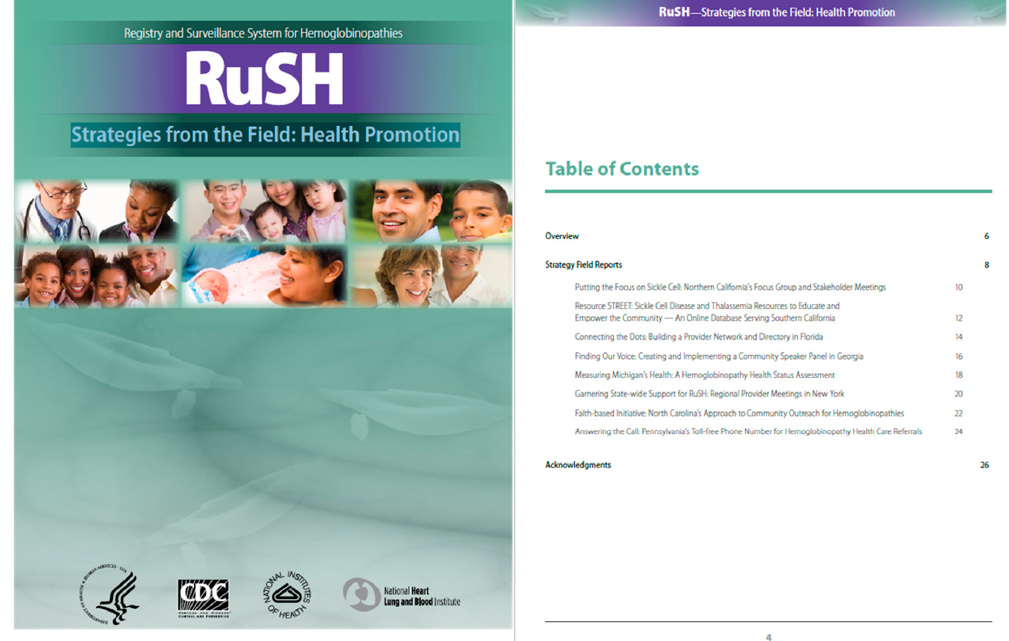
Figure 2. Report on health promotion strategies for sickle cell diseases from eight sites in the United States. The location of the participating sites in the report are California, Florida, Georgia, Michigan, New York, North Carolina and Pennsylvania.